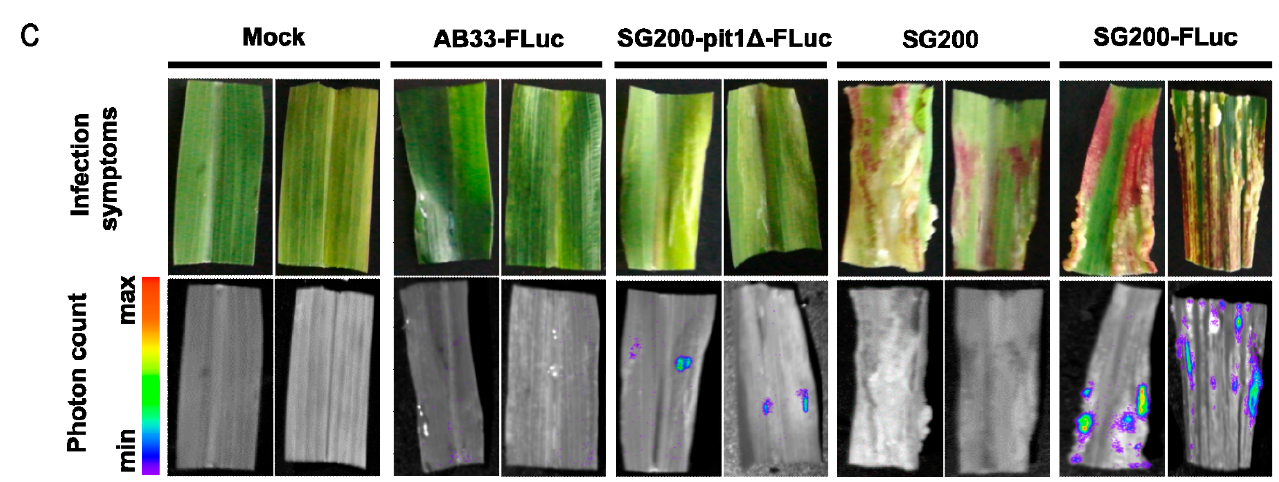
Figure 4. Quantitative monitoring of infections symptoms in maize infection assays. ( A ) Symptom scoring of infected maize plants at 12 dpi. As expected, pathogenicity increased from AB33 (nonvirulent) via SG200-pit1 Δ (virulent up to entry) to SG200 (fully virulent). ( B ) Luminescence-based analysis of fungal proliferation in plant tissue. Symptoms of each sample were scored and are indicated by colored dots. The non-pathogenic strain AB33-Fluc showed background luminescence, as the fungus was not able to proliferate and produce biomass in planta. SG200-pit1 ∆ -Fluc infection resulted in luminescence corresponding to fungal entry, but lack of proliferation in the host plant. For SG200-Fluc, high photon counts were detected, which corresponds to the fully virulent phenotype of the strain. ( C ) Pictures taken with the NightOwl device during photon count measurement. Intense luminescence signals were found in all tissues with high amounts of fungal biomass, mostly in tumors filled with fungal